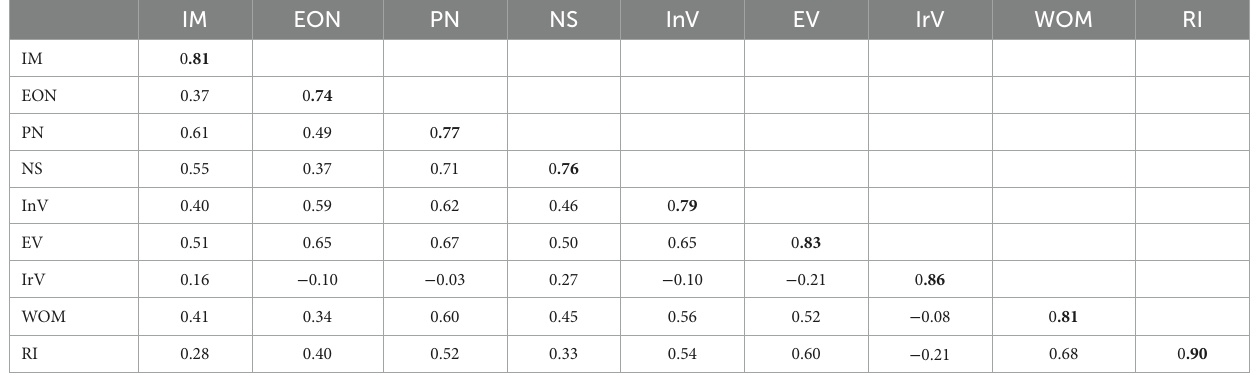
TABLE 4 Correlations among the latent constructs.